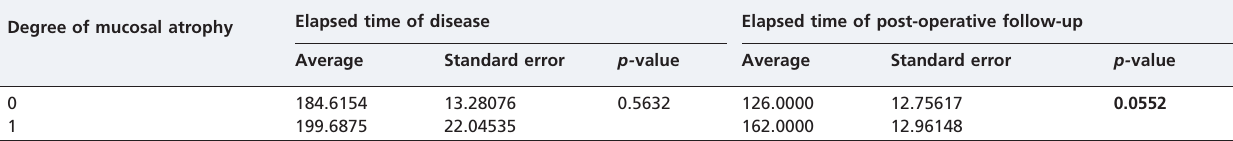
Table 2 - Correlation between elapsed times of disease and post-operative follow-up with the degree of mucosal atrophy. Degree of mucosal atrophy